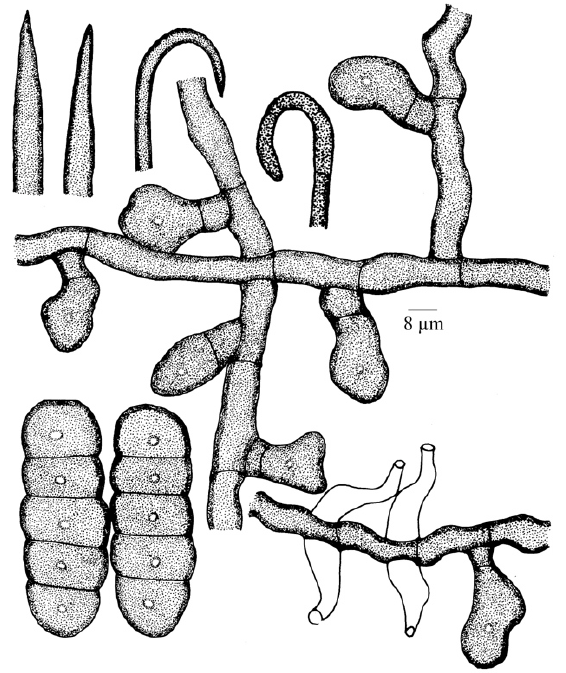
Figure 9. Meliola canarifolia sp. nov. a - Appressorium, b - Phialide, c - Apical portion of the mycelial setae; d -